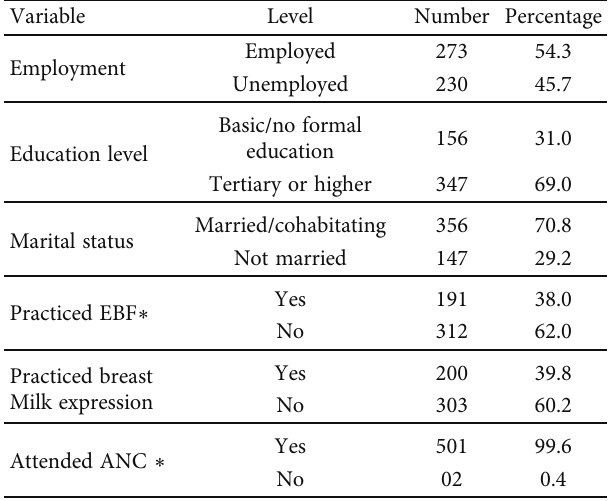
Table 1: Demographic distribution and characteristics of mothers ( N =503).